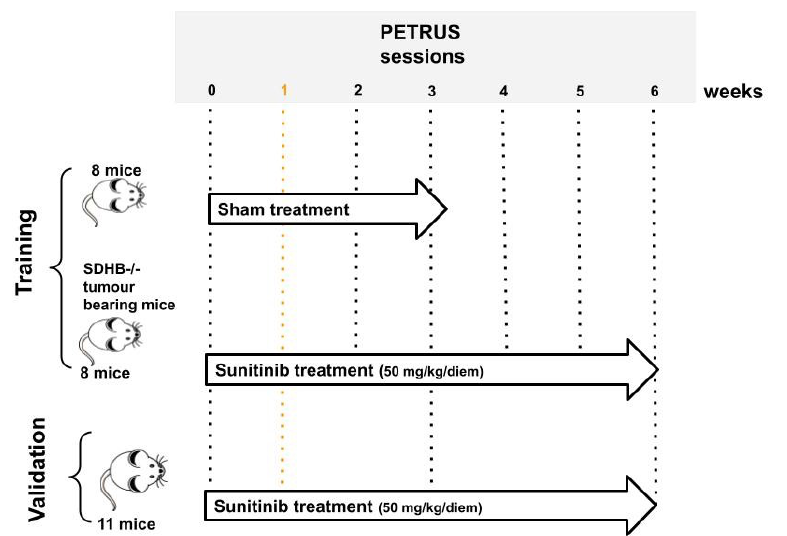
Figure 2. Database generation process. Mice in the training group were divided into two groups: sunitinib-treated and sham-treated. Eight mice from each group were scanned with PETRUS before and after 1, 2, and 3 weeks of treatment. Sinitinib-treated mice were also imaged at 4, 5, and 6 weeks of treatment. Mice of the independent validation set were sunitinib-treated and scanned at baseline and at weeks: 1, 3, and 6 of the